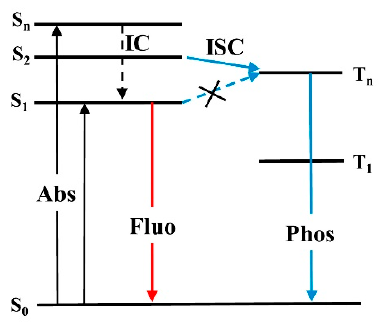
Figure 16. The proposed mechanism for the anti-Kasha properties of 64 film. Reprinted from [65], Copyright 2020, with permission from Elsevier. Copyright 2020, with permission from